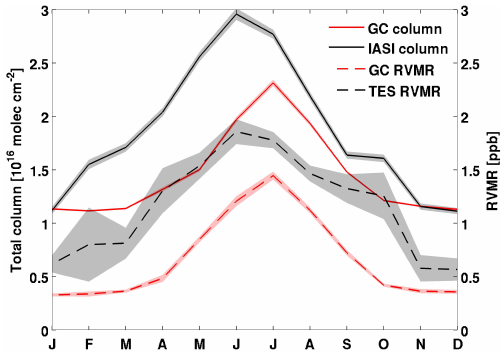
Fig. 4. Seasonal cycle in atmospheric methanol over midlati- tudes for 2009. Shown are methanol column amounts simulated by GEOS-Chem (base-case simulation, red solid line) and mea- sured by IASI (black solid line), and representative volume mixing ratios (RVMR) simulated by GEOS-Chem (base-case simulation, red dashed line) and measured by TES (black dashed line). TES RVMR data include only those observations with DOFS > 0.5. The data represent an average over the northern midlatitude regions of Fig. S2, and shaded areas show the standard error about the